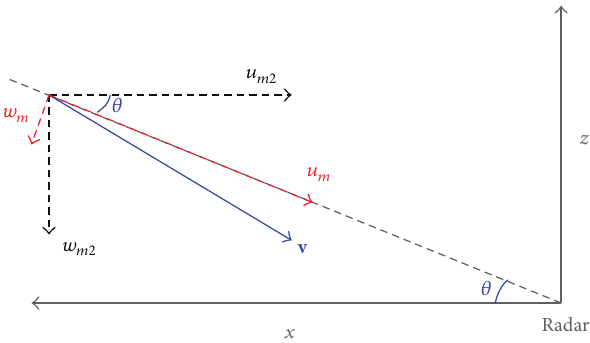
Figure 1: Sketch of geometric relationship between the components of (𝑢 𝑚2 ,𝑤 𝑚2 ) and (𝑢 𝑚 , V 𝑚 ) , plotted by the dashed black and red arrows, respectively, for the same vector k plotted by the solid blue arrow. The radar beam is plotted by the gray dashed line, and 𝜃 is the slope angle of the radar